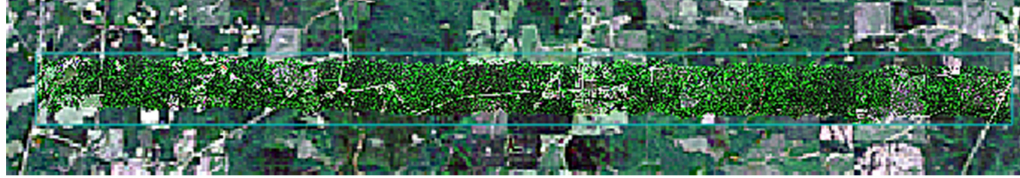
Figure 12. OLI and multispectral NIS image registration over the Lenoir Landing (LENO) (AL)